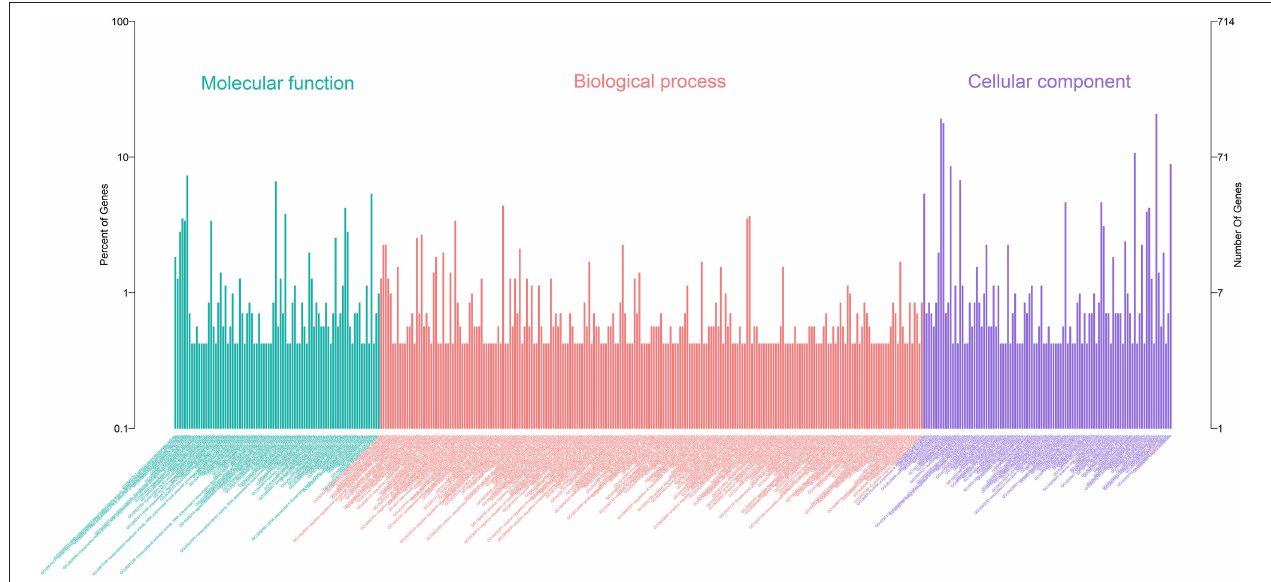
FIGURE 7 | Annotation of DEmiRNAs using Gene Ontology (GO) in mammary epithelial cells.